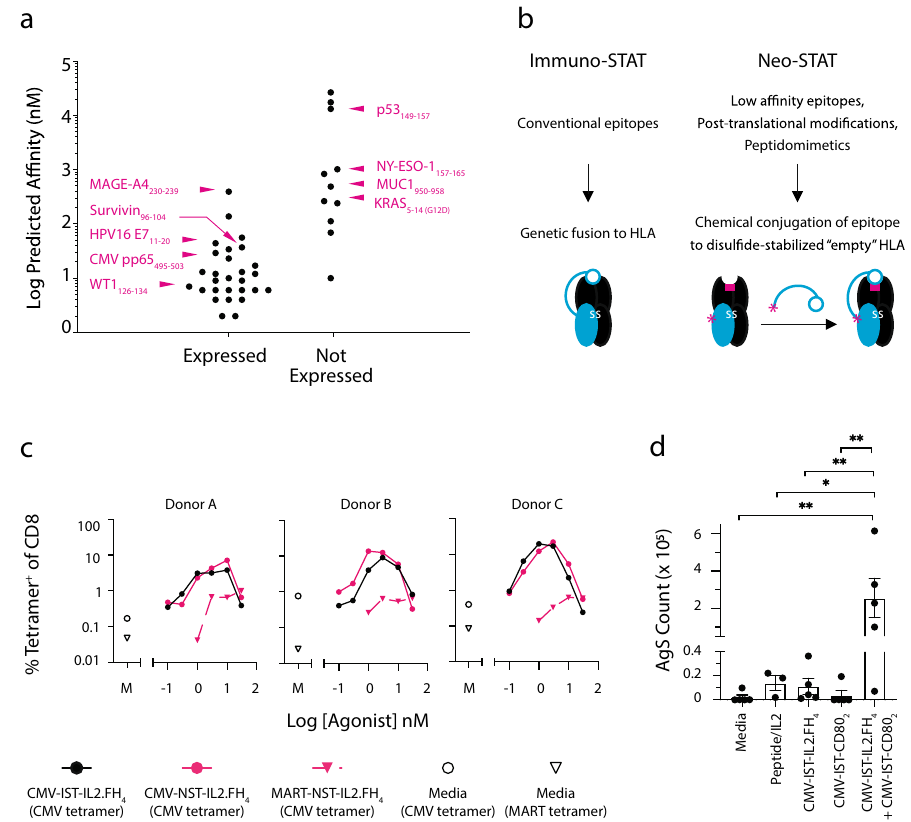
Figure 2. Immuno-STAT and Neo-STAT epitope and co-modulatory flexibility. ( a ) NetMHC-predicted peptide binding affinity to HLA-A*0201 versus expressibility on the Immuno-STAT framework, highlighting select epitopes. Data from two independent expression trials with minimum expressibility criteria of 10 mg/L and 50% species of interest by SDS-PAGE. ( b ) Differential application of Immuno-STAT and Neo-STAT frameworks by epitope type. ( c ) Dual-tetramer frequency of CMV-specific human PBMC T cells following ten day culture with CMV Neo-STAT (CMV-NST-IL2.FH 4 ), MART-Neo-STAT (MART-NST-IL2.FH 4 ), CMV-IST-IL2.FH 4 , or media (M). Data are single measurements at each concentration for three donors. ( d ) CMV-specific human PBMC T cell counts following ten day culture of CMV-IST-IL2.FH 4 -responsive donors with CMV-IST-IL2.FH 4 and/or CMV-IST-CD80 2 versus peptide and media controls. Data represent single measurements per condition from 3 to 5 donors. Statistical significance *( P ≤ 0.05) or **( P ≤ 0.01) assessed by one-tailed paired ratio T